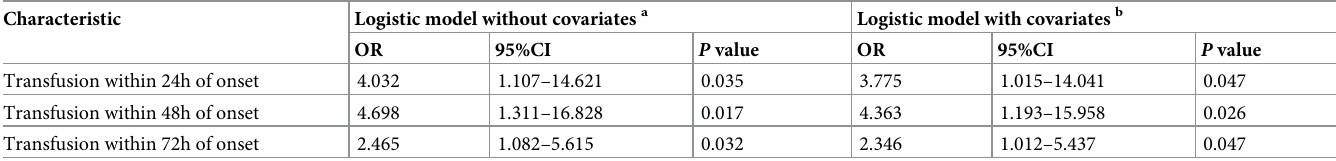
Table 5. Logistic analysis for NEC for the combined effects of severe anemia and transfusion.